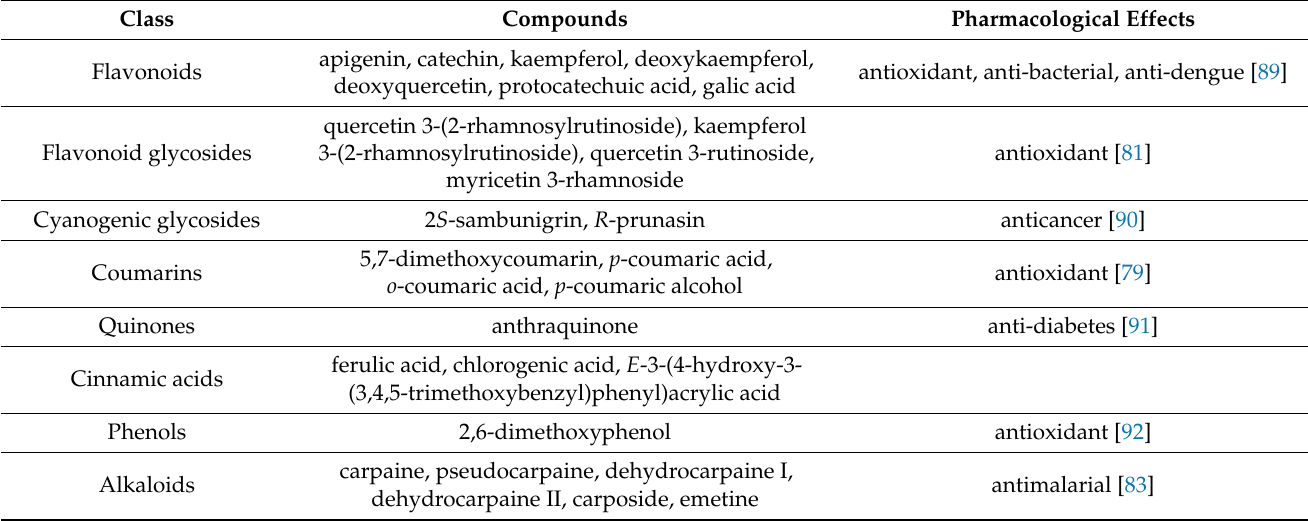
Table 3. The phytochemical substances reported to be present in papaya